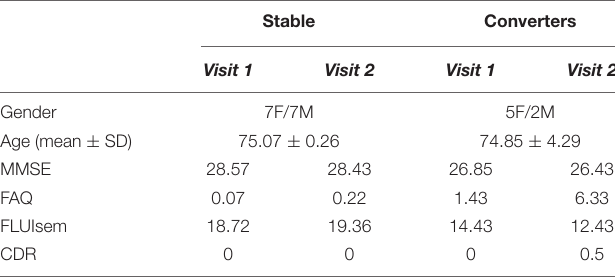
TABLE 1 | Demographics and neuropsychological